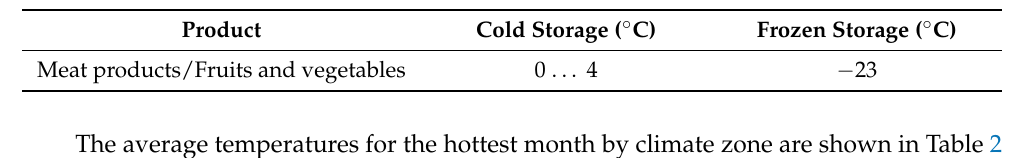
Table 1. Indoor temperature.